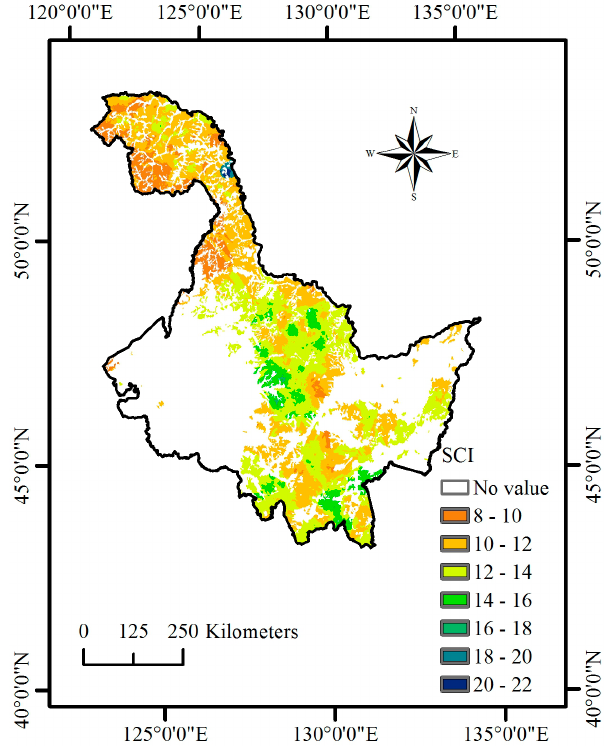
Figure 4. Spatial distribution of site class index (SCI) values in Heilongjiang Province, China.